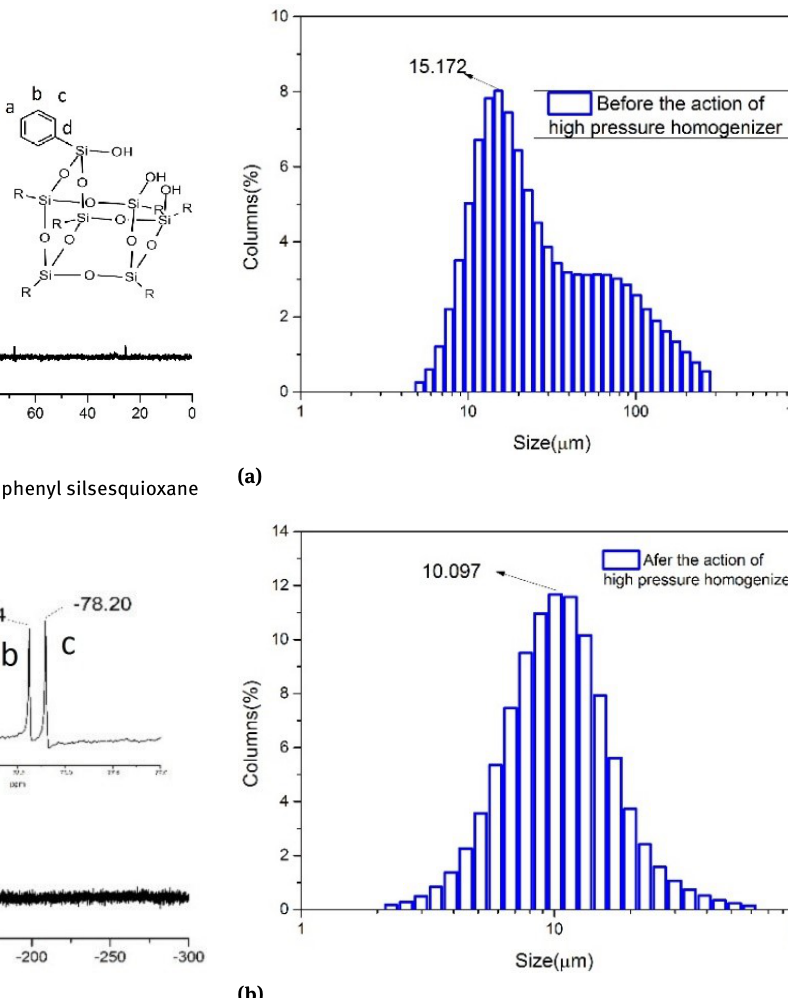
Figure 8: The comparison of wollastonite particle size before and after the action of high pressure homogenizer: a) before the action b) after the action